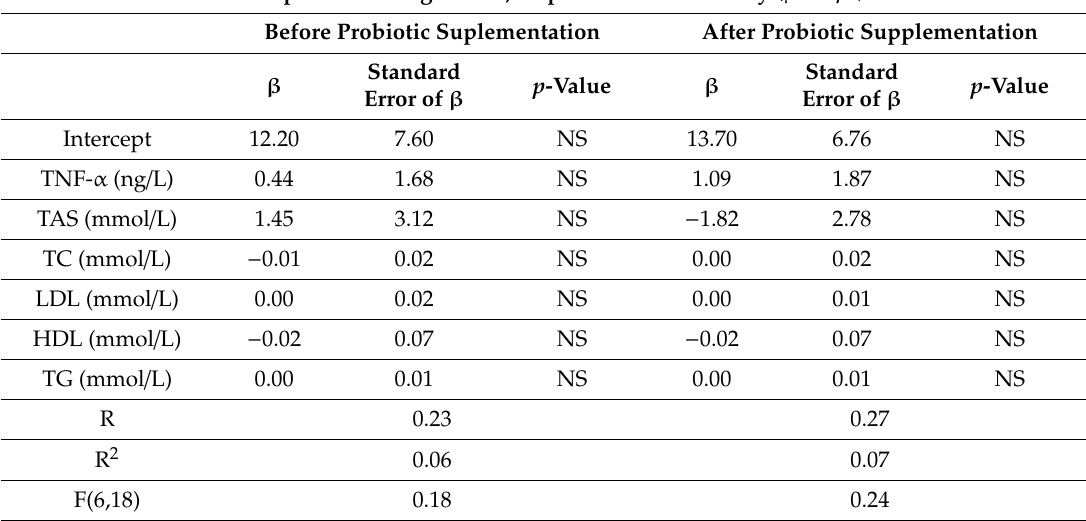
Table 5. Multiple linear regression analysis of Hcy concentration dependence on TC, HDL, LDL-cholesterol, TG, TNF- α and TAS level before and after probiotic supplementation. Multiple Linear Regression, Dependent Variable Hcy ( µ mol /